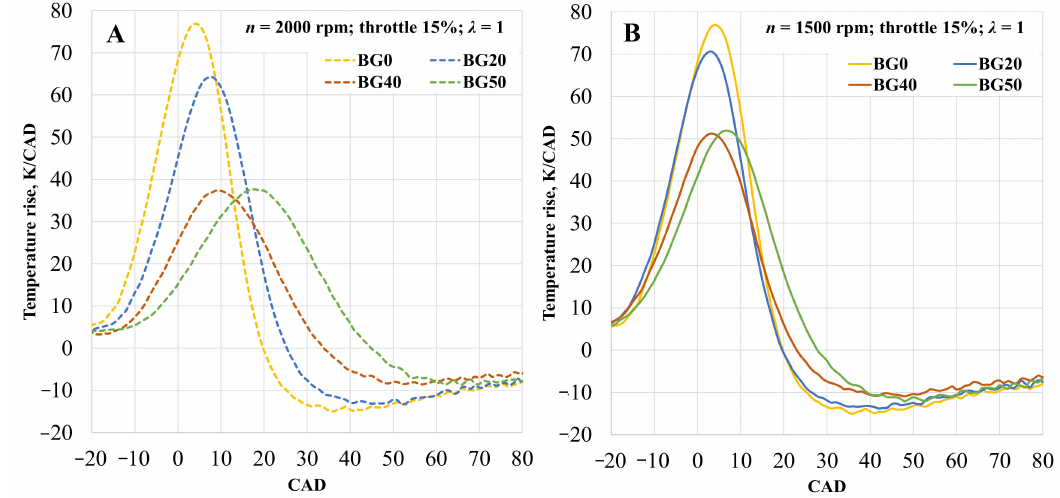
Figure 9. Change of the in-cylinder temperature rise depending on the volumetric fraction of CO 2 . ( A ) Constant ST, ( B ) Optimal ST.